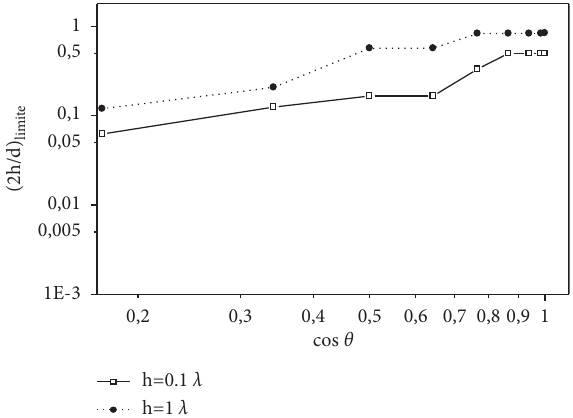
Figure 3: Limit slope (2 h / d ) cidence θ